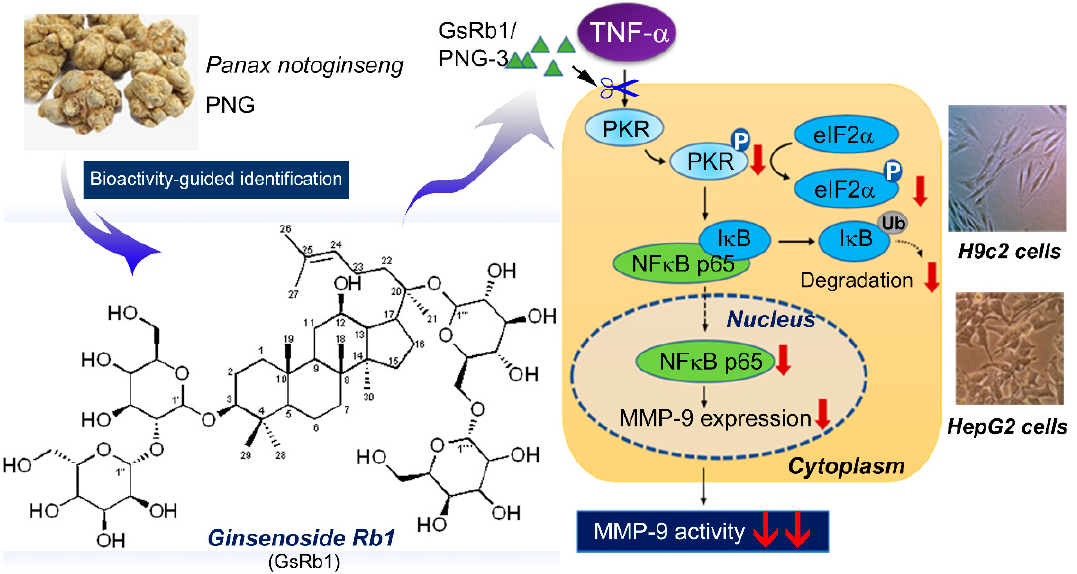
Figure 1. The anti-MMP-9 activity of the active fraction of PNG-3 and Ginsenoside Rb1 (GsRb1) from Panax notoginseng and their mechanism of action.